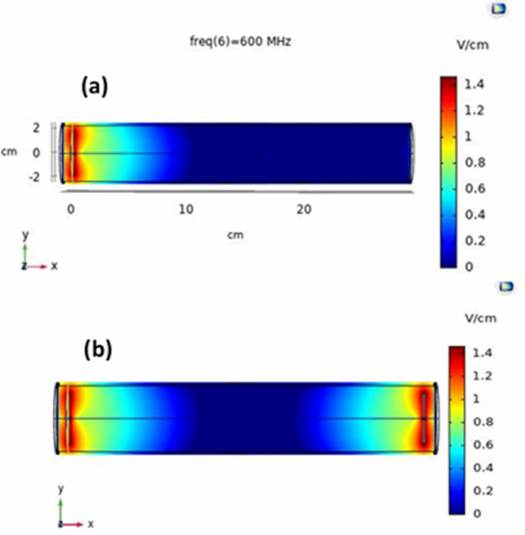
Figure 11. ( a ) The E-field distribution of the antenna in sandstone saturated with oil, brine and nanofluid at 600 MHz and ( b ) the E-field distribution using a double antenna, with the transmitter placed in the injection and production